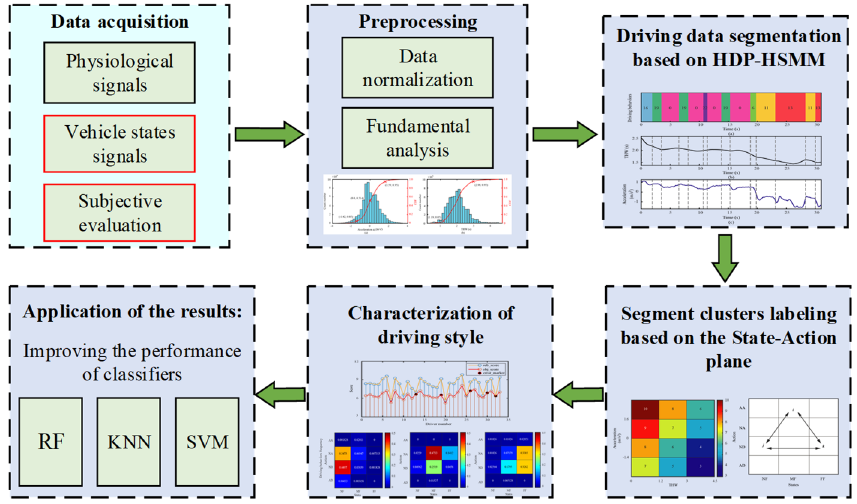
Figure 6. The proposed framework to analyze driving styles based on the State–Action semantic plane.